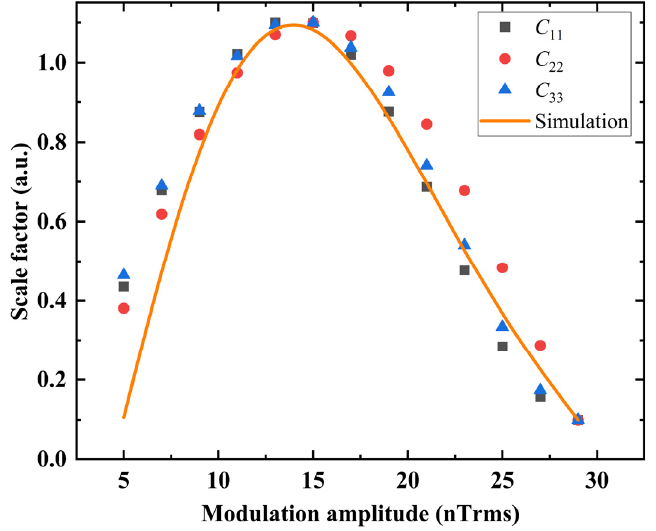
Figure 4. Three-channel scale factors under different modulation amplitudes. The square, round, and triangular points represent the experimental results. The orange curve is the simulation result.